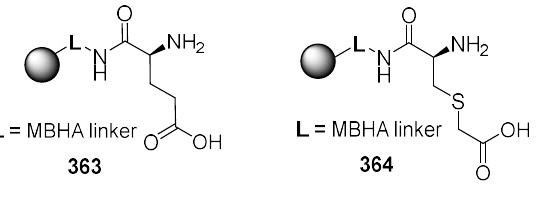
Figure 4. Bifunctional BBs used in U-4C-3CR.